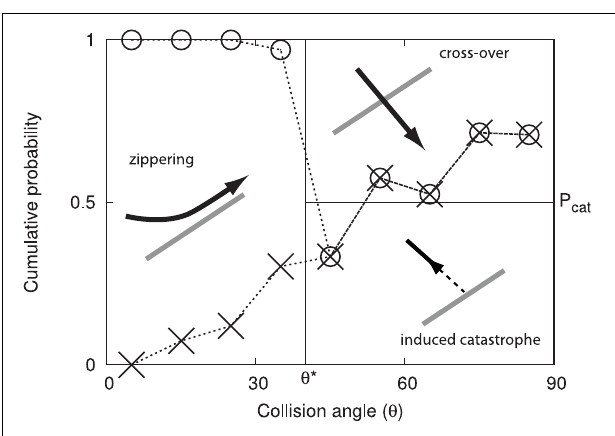
FIGURE 2 | Angle dependent outcomes of microtubule collisions. Graphical depiction of the microtubule interaction model, expressed as cumulative probabilities as a function of the interaction angle θ . The experimental data by Dixit and Cyr [7] are indicated using dashed lines and symbols: induced catastrophes below the crosses, cross-overs above the circles and zippering in